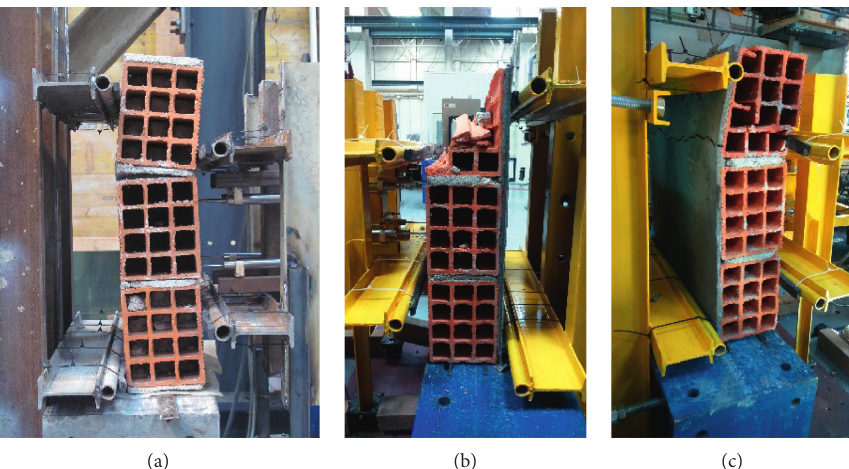
Figure 6: Test results obtained by Barros [124]: damages observed after the flexural strength tests parallel to the horizontal bed joints. (a) As- built specimens, (b) Group A, and (c) Group